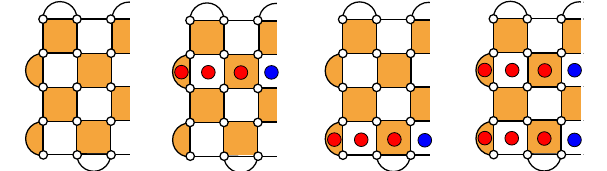
FIG. 17. All allowed bulk and boundary configurations for Y noise illustrated for the boundary state for the third column j ¼ 3 of a 5 × 5 code on the rotated layout for the trivial coset f 0 ¼ I . The product of the dotted checks must result in only I and Y errors on Q 3 (and no X or Z errors). Blue dots represent the boundary configuration, while red dots represent the correspond- ing bulk configuration. Blue dots must be connected to a two- qubit check on the left boundary by a string of red dots. The fact that these strings never overlap and are absorbed at the left boundary implies that the boundary variables are uncorrelated, and, therefore, there is no entanglement in the boundary